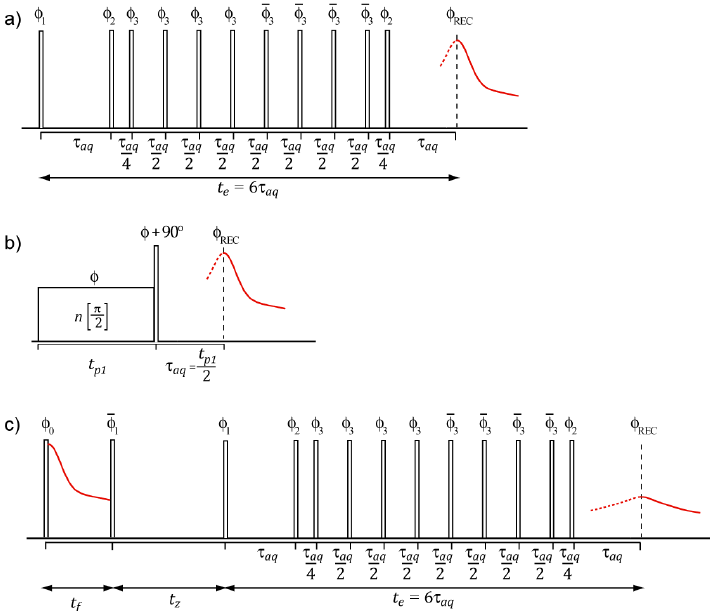
Figure 1. Schemes of the NMR pulse sequences used in this article. ( a ) Mixed ‐ Magic Sandwich Echo (mixed ‐ MSE). ( b ) Rhim–Kessemeier (RK). ( c ) Dipolar Filtered Magic Sandwich Echo (DF ‐ MSE). The phase cycling used in the pulse sequence are provided in references [2–4,7]. REC: refer to the receiver phase.